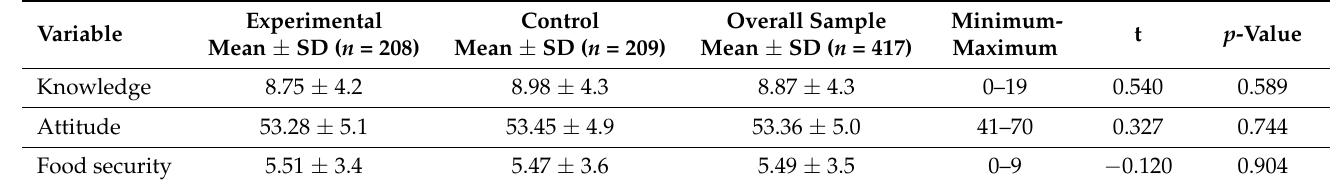
Table 3. Mean Scores for Knowledge, Attitude and Food Security at Baseline.